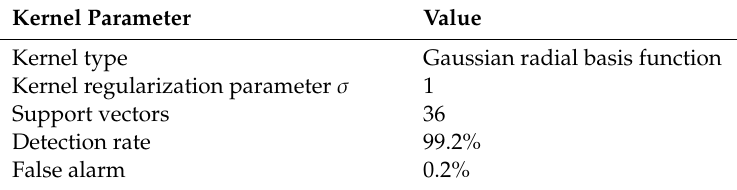
Table 5. Performance parameters of the SVM with Gaussian radial basis function.